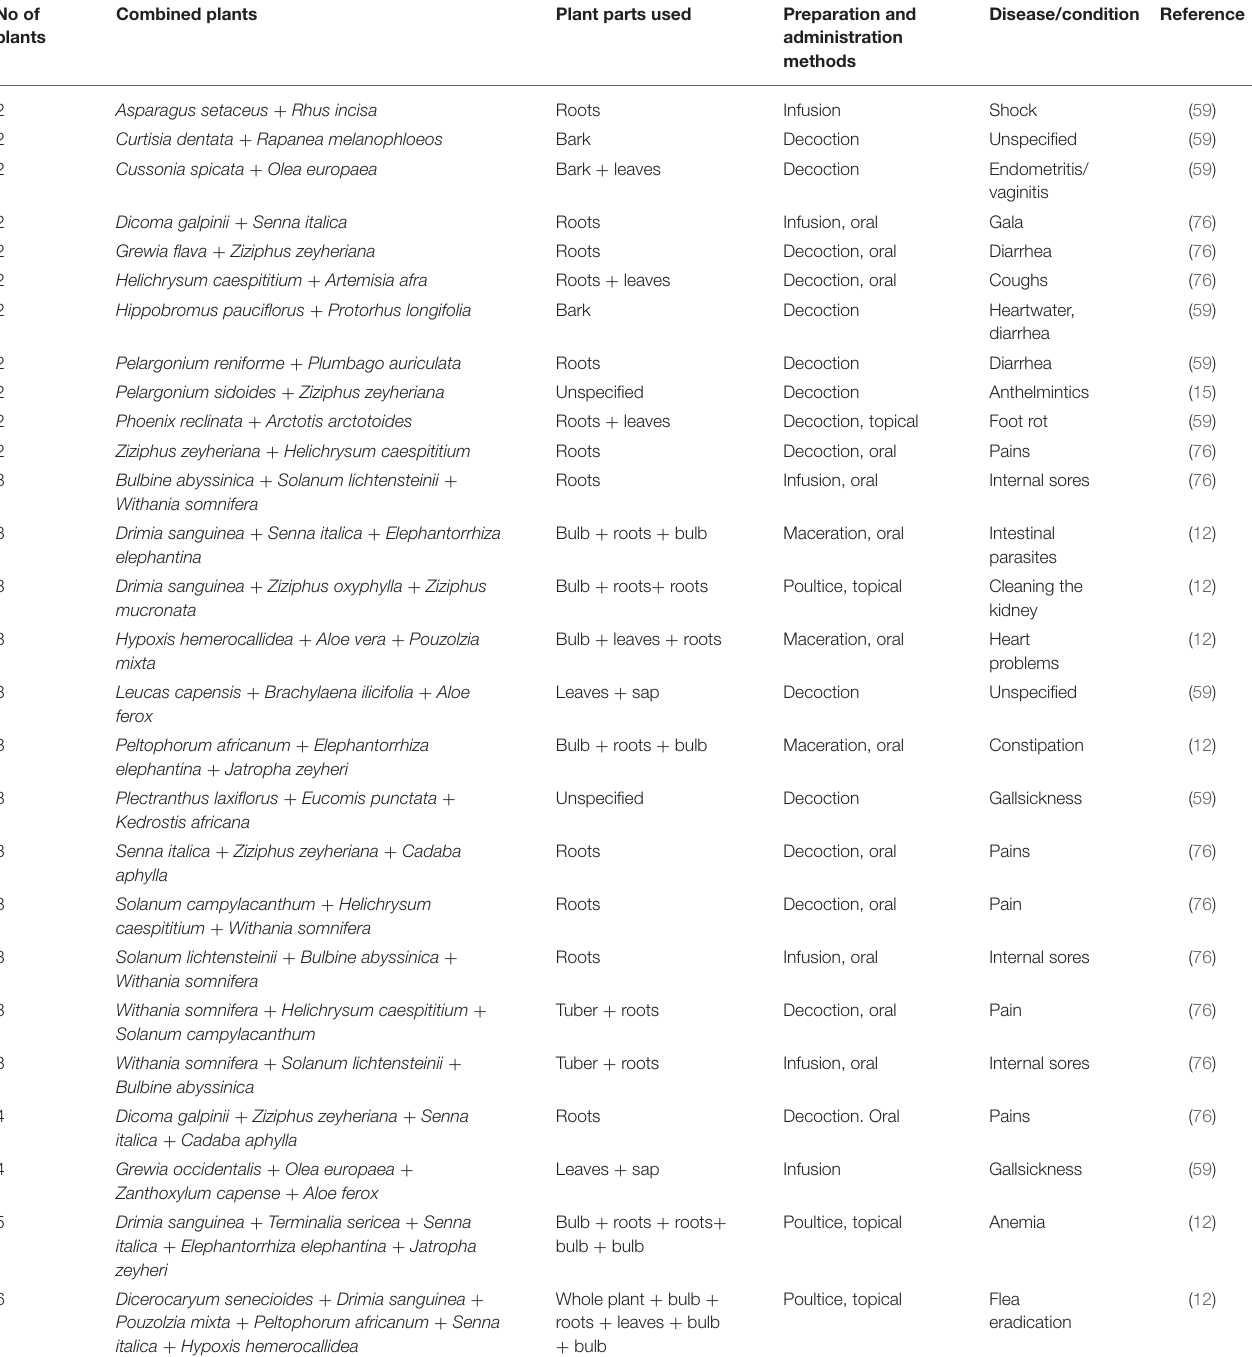
TABLE 2 | Examples of plants used in combination therapy for treating cattle diseases in South Africa. No of